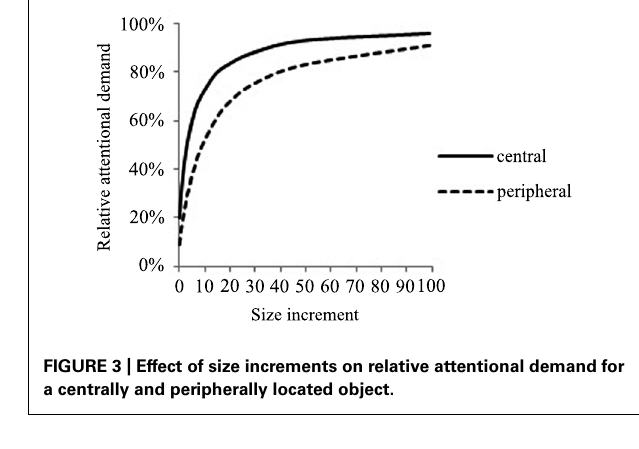
FIGURE 3 | Effect of size increments on relative attentional demand for a centrally and peripherally located